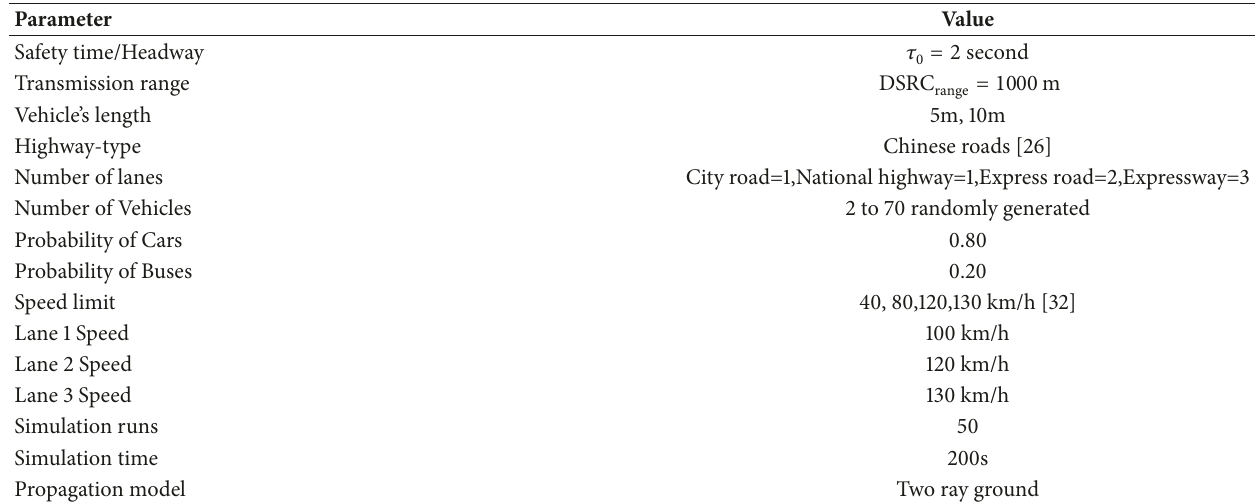
Table 3: Parameters utilized for MCDP